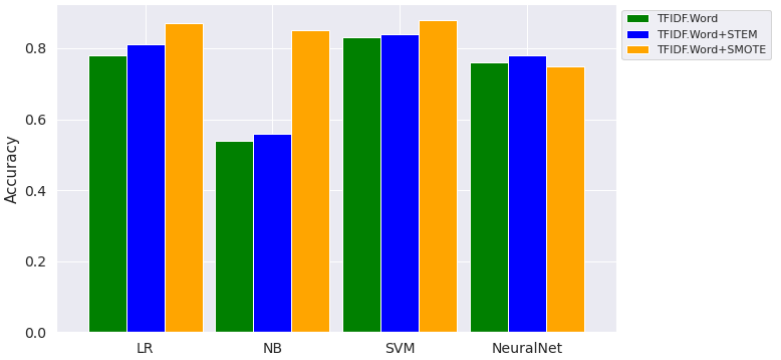
Figure 4. Effects of Stemming and SMOTE on Performance of Topic